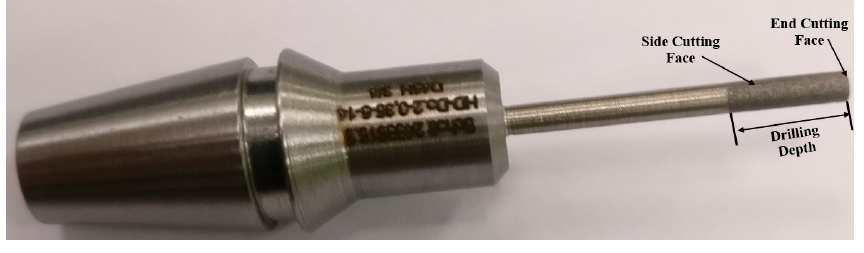
Figure 3. RUD tool. Figure 3. RUD tool.